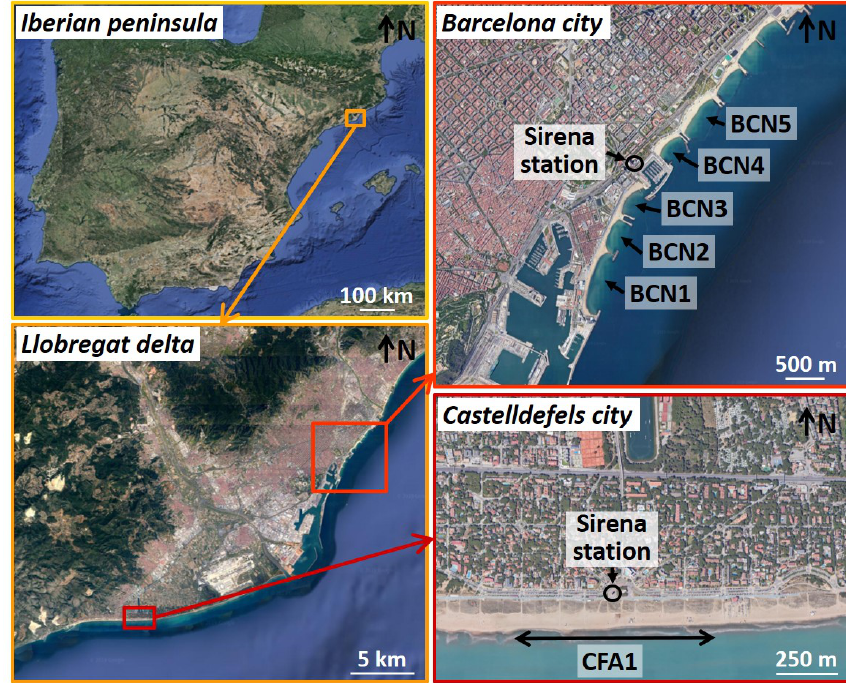
Figure 1. Geographical location of the studied beaches in Castelldefels and Barcelona cities (Spain) (Source: Google maps, images from TerraMetrics, CNES/Airbus, Institut Cartogràfic de Catalunya, Landsat/Copernicus, Maxar Technologies).